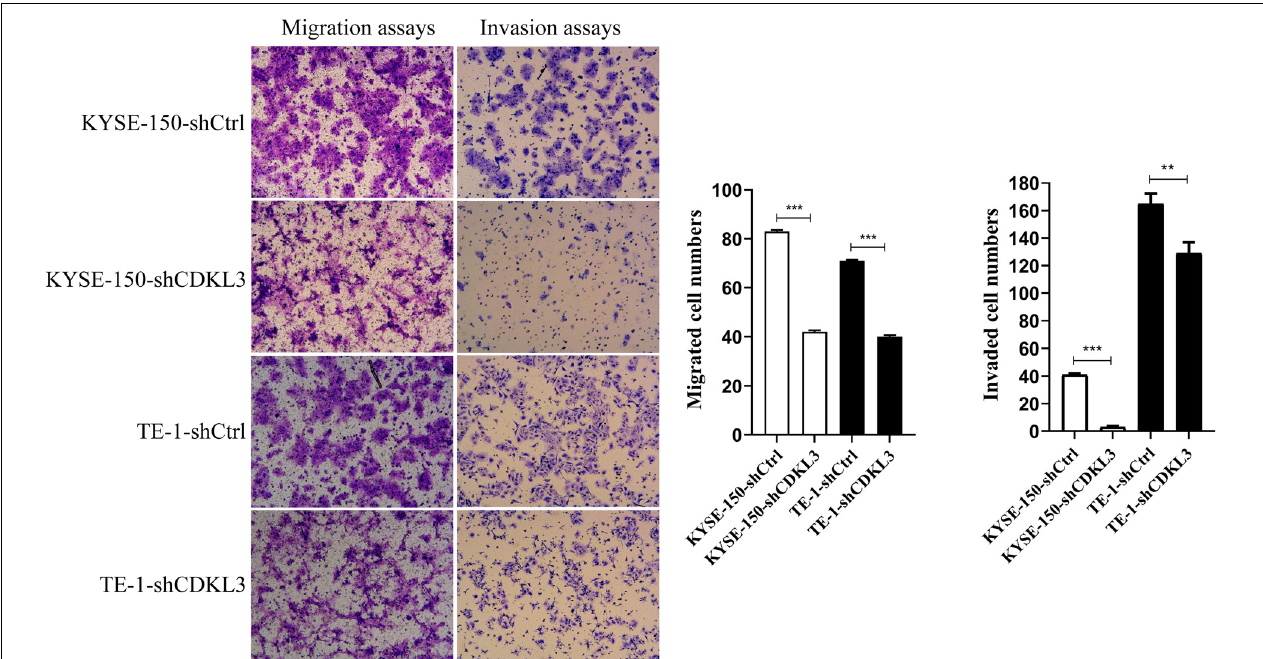
FIGURE 3 | Using transwell-with or without Matrigel assay, CDKL3 knockdown decreased the numbers of migrated and invaded cells in the shCDKL3 group compared with the shCtrl group. Data were represented as the mean ± SD of three separate experiments. ** P < 0.01, *** P < 0.001.